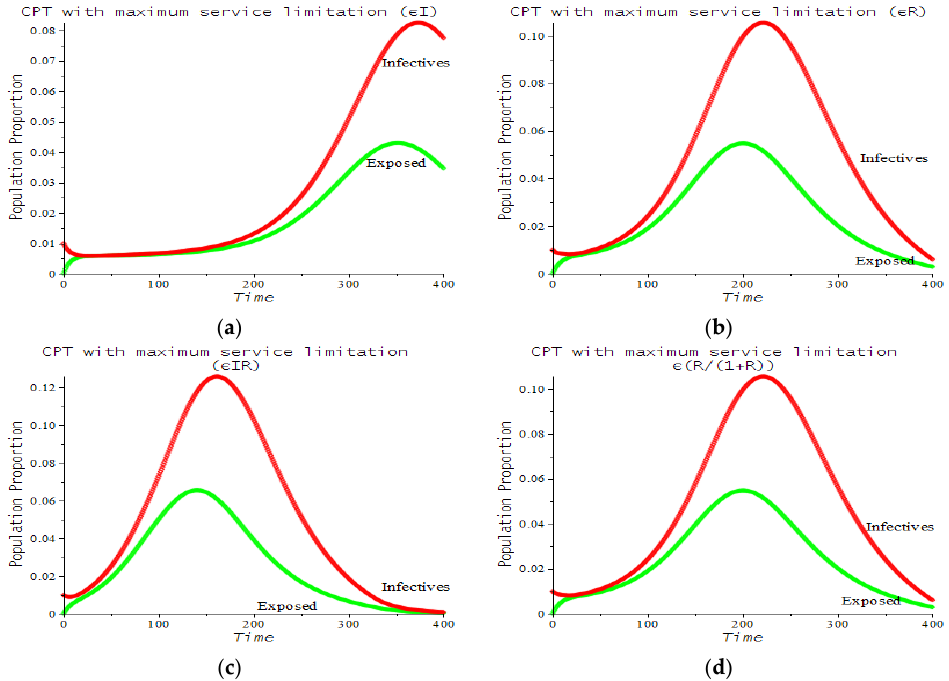
Figure 9. Plots of the effect of various Maxserv CPT scenarios on the dynamics of infective (red) and exposed (green) classes, with the assumption that the CPT intervention is conducted from the beginning of the pandemic. The scenarios and parameters for the graphs in ( a – d ) are as in Table 2.